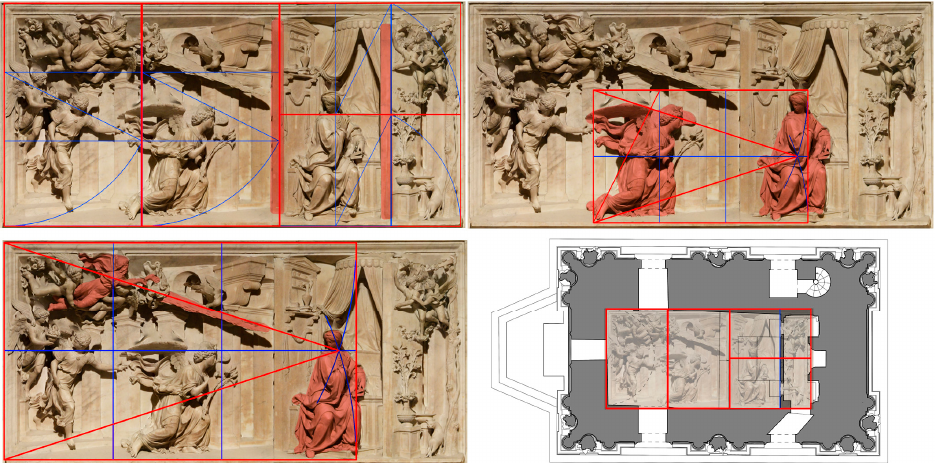
Figure 4. The golden ratios found in the low relief of the Annunciation. Upper left: the proportions of the entire panel defined according to four golden rectangles; upper right: rectangle and golden triangle that frame the figures of the angel and Mary, and God and Mary; lower left: the golden triangle that defines the God/Mary ratio (slope of the side); lower right: superposition of the panel with the plan of the Holy House, in which the comparison of the division of the spaces is